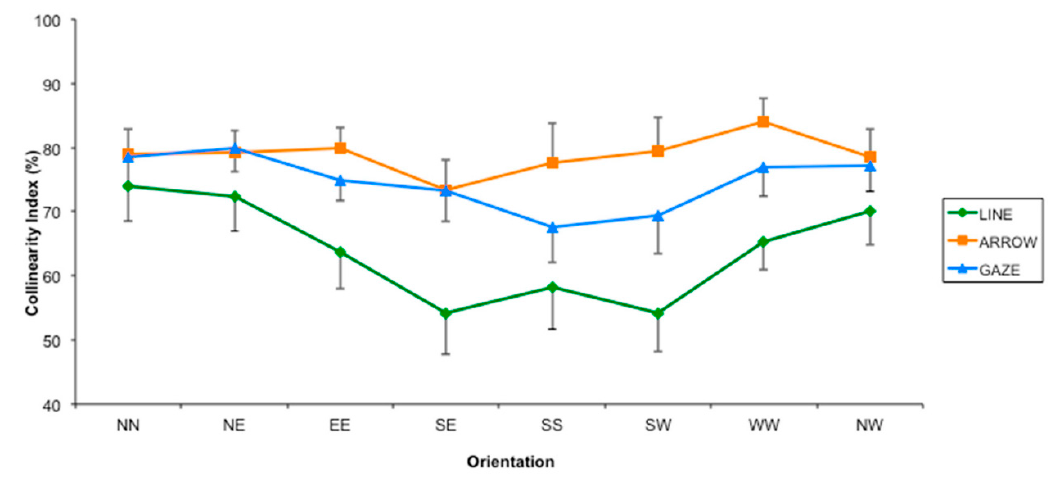
Figure 8. Collinearity Index (indicating the percentage of responses towards the collinear direction) for the three types of stimuli as a function of the eight possible orientations in Experiment 2. Error bars indicate the Standard Error.